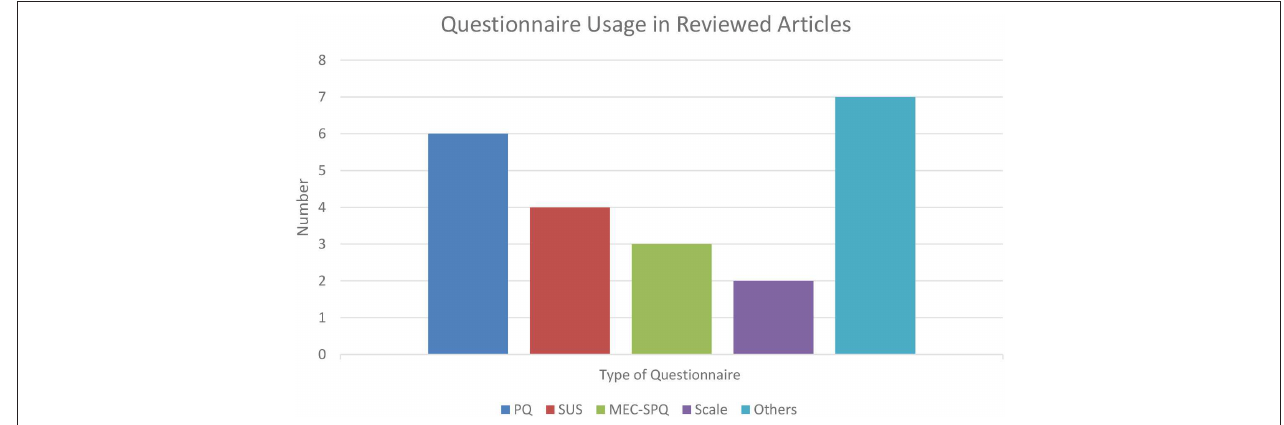
FIGURE 2 | Usage of presence questionnaires in the reviewed articles. See the Appendix for full questionnaire